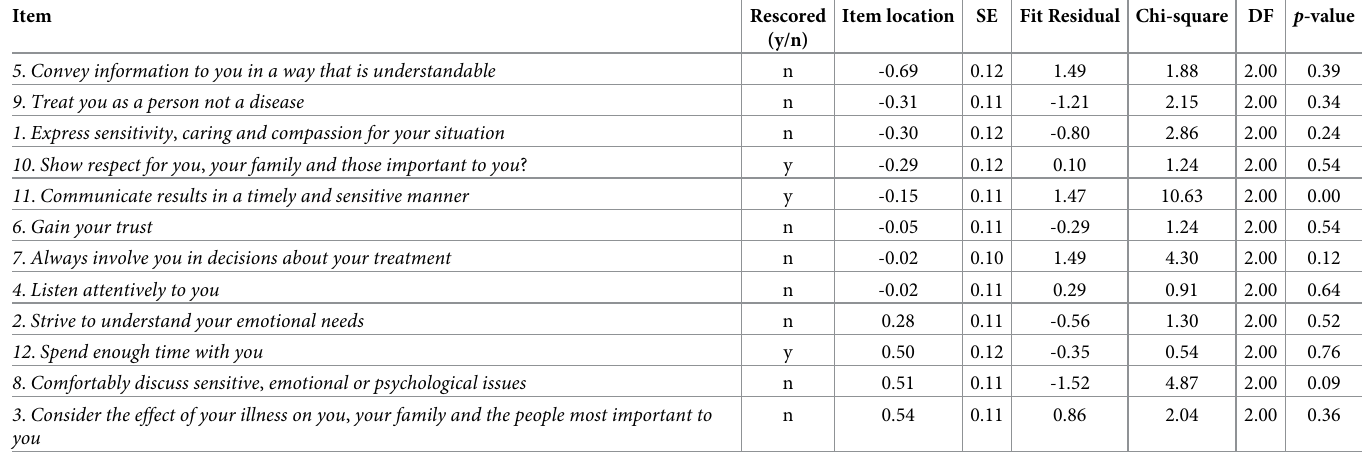
Table 4. Rasch measurement theory statistical indicators of item fit by location